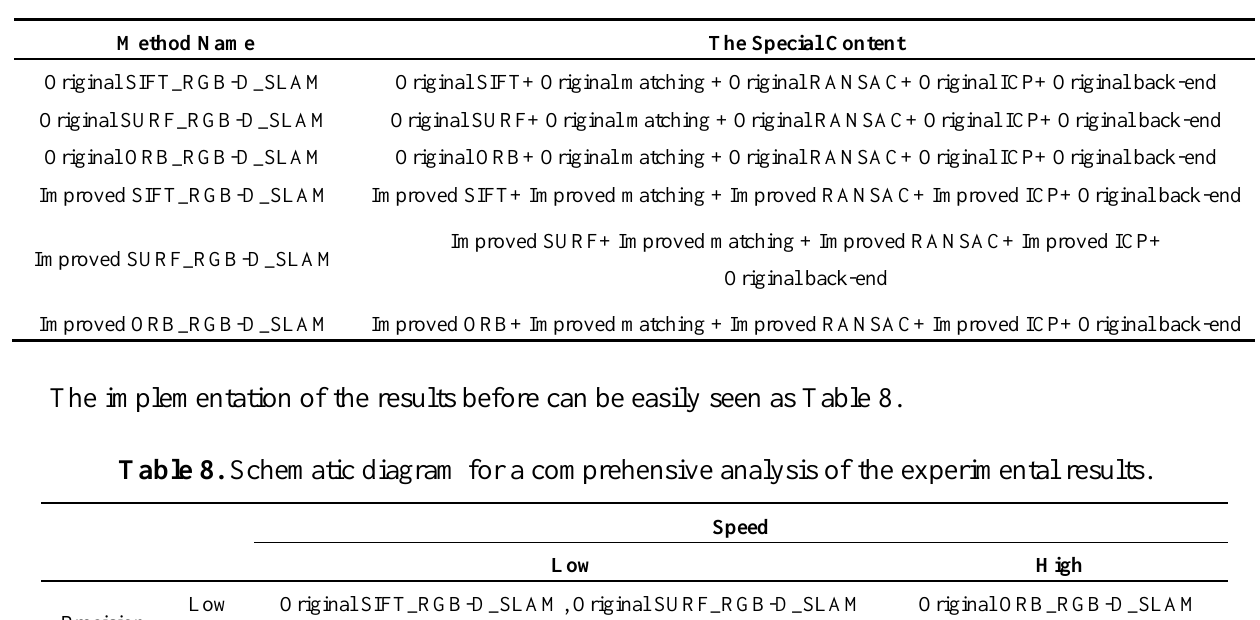
Table 7. The name for method definition table.